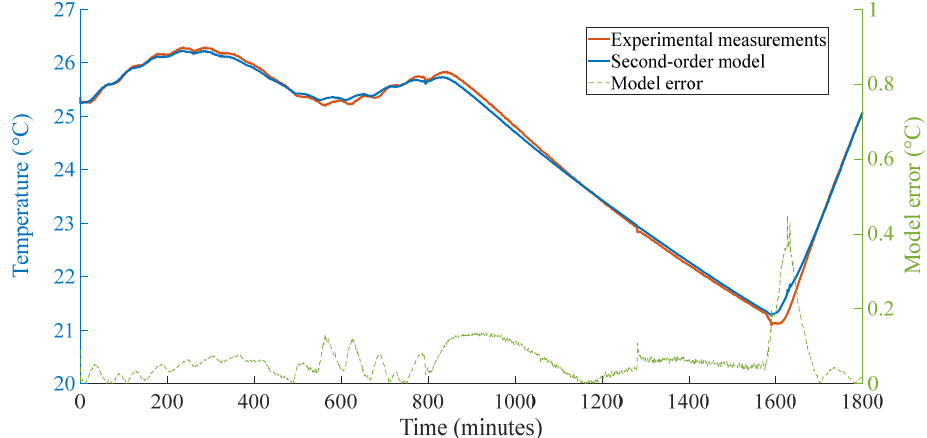
Figure 5. Second ‐ order grey ‐ box model versus experimental measurements and model error.